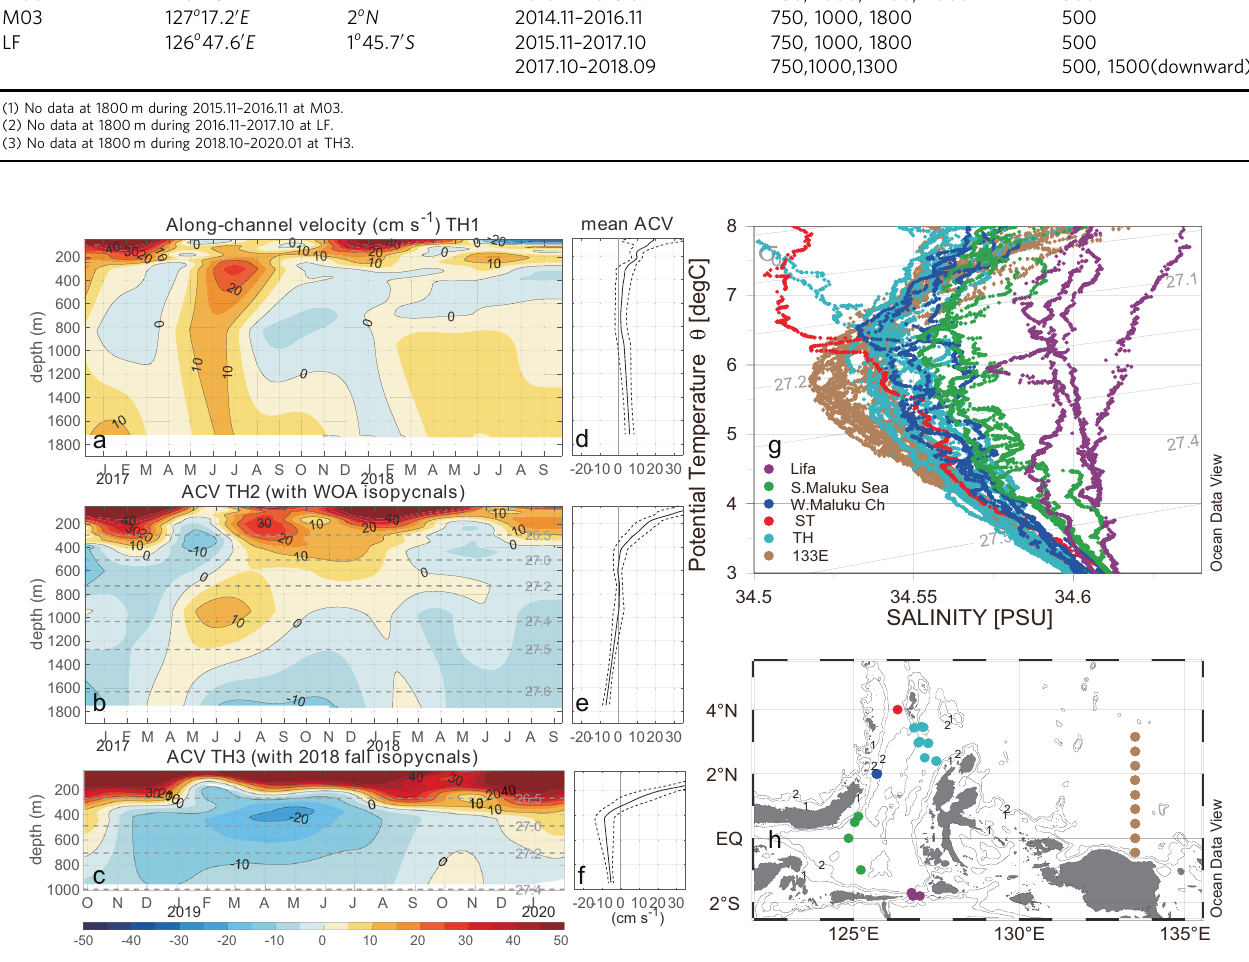
Fig. 2 TH channel velocity and Maluku Sea water masses properties. The 120-day low-passed daily along-channel velocity (ACV) time series ( a – c ) and their mean pro fi les ( d – f ) of moored current meter measurements in the TH Channel, showing intrusions of Paci fi c intermediate waters into the Maluku Sea through the northern TH Channel. The ACV is de fi ned as 67° clockwise from due north perpendicular to a section from Talaud to Halmahera Islands. Dash lines mark the standard errors of the means at 95% signi fi cance. The isopycnal depths calculated from the temperature and salinity pro fi les of the World Ocean Atlas 2013 version 2 and of the fall 2018 cruise are marked in ( b ) and ( c ). g Potential temperature-salinity relations of the intermediate water masses in the TH Channel and the Maluku Channel, showing the AAIW salinity minimum increasing from the Paci fi c western boundary (133°E sections) through the TH Channel to the western Maluku Channel. The only one CTD pro fi le in the Sangihe-Talaud Channel (red dot in g and h ) is also shown to be similar to the western Maluku Channel pro fi les with the AAIW properties. Dots in ( h ) are the CTD stations of ( g ), with the colors used to represent the straits or